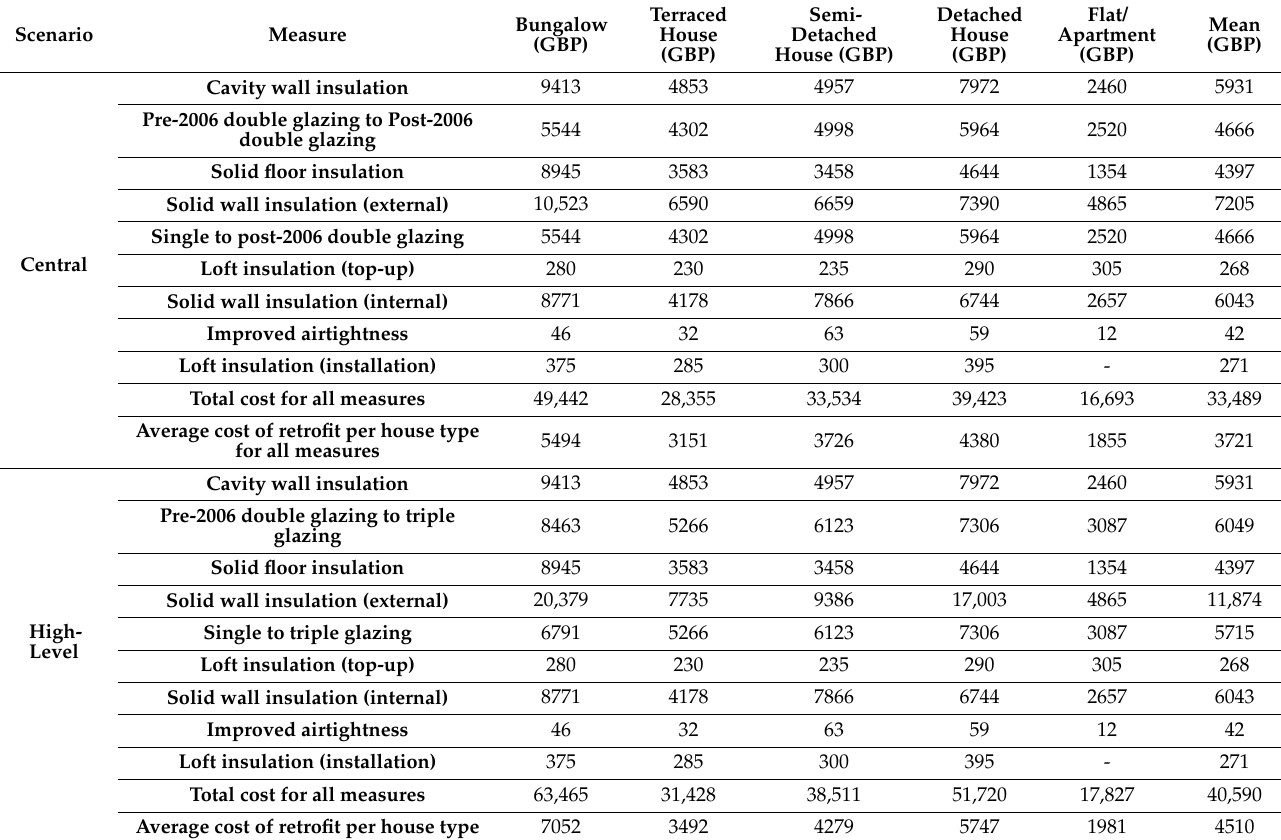
Table 8. Retrofit cost breakdown per house type per